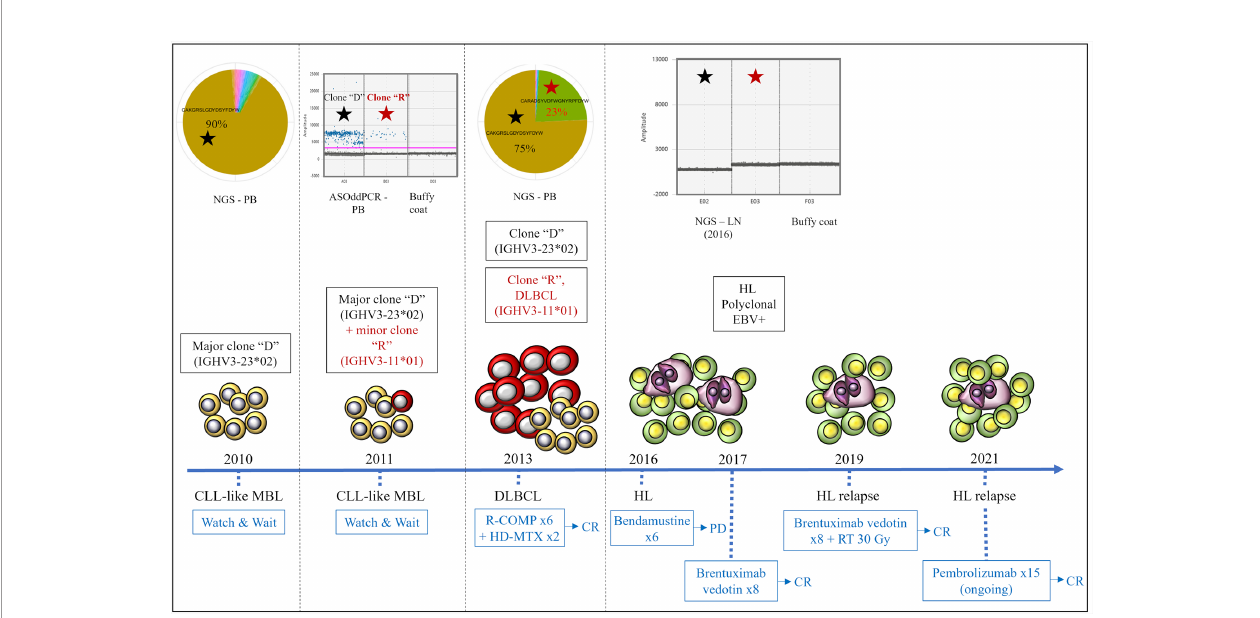
FIGURE 2 | Clonal relationships by Ig-rep and ASO-ddPCR and clinical evolution of the three lymphoid neoplasms. Clone “ D ” (indicated with a black star) was detected in the PB sample collected at the time of MBL diagnosis and was persistent in the PB collected at the time of DLBCL. Clone “ R ” (i.e., the clone identi fi ed in the lymph node biopsy at the time of DLBCL transformation, indicated with a red star) was undetectable by NGS of Ig-rep in the PB sample collected at the time of MBL diagnosis, whereas it became detectable by ASO-ddPCR in an interim PB sample collected during the “ watch & wait ” period (where it coexisted with clone “ D ” ). Neither clone “ D ” nor clone “ R ” were detectable in the lymph node specimen collected at the time of HL. ASO-ddPCR, allele-speci fi c oligonucleotide-droplet digital PCR; NGS, next-generation sequencing; Ig-rep, immunoglobulin repertoire; PB, peripheral blood; LN, lymph node; DLBCL, diffuse large B-cell lymphoma; HL, Hodgkin ’ s lymphoma; MBL, monoclonal B-cell lymphocytosis; EBV, Epstein – Barr virus; R-COMP, rituximab, cyclophosphamide, liposomal doxorubicin, vincristine, prednisone; HD-MTX, high-dose methotrexate; CR, complete response; PD, progressive disease; RT,